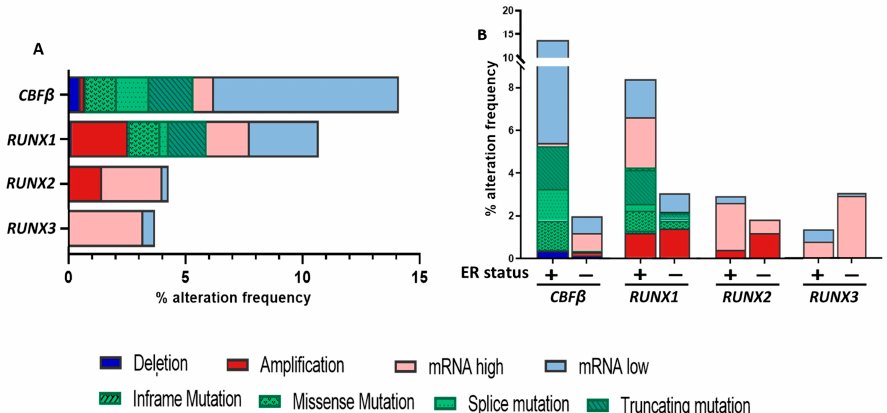
Figure 1. ( A ) Genetic alteration frequencies for each of the 3 RUNX genes and CBFB in all breast cancer patients. ( B ) Data as in A but separated by ER status of breast tumors to illustrate the different spectrum of RUNX and CBFB alterations dependent on disease subtype. Data acquired from the METABRIC dataset using cBioportal accessed January 2023